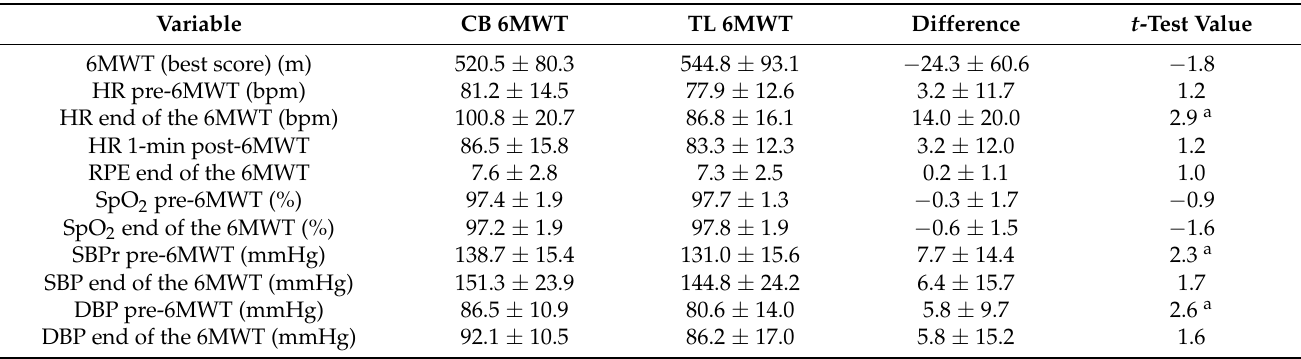
Figure 3. Correlation between the CB and TL 6MWT. Table 2. Evaluation of the differences of the CB and TL 6MWT